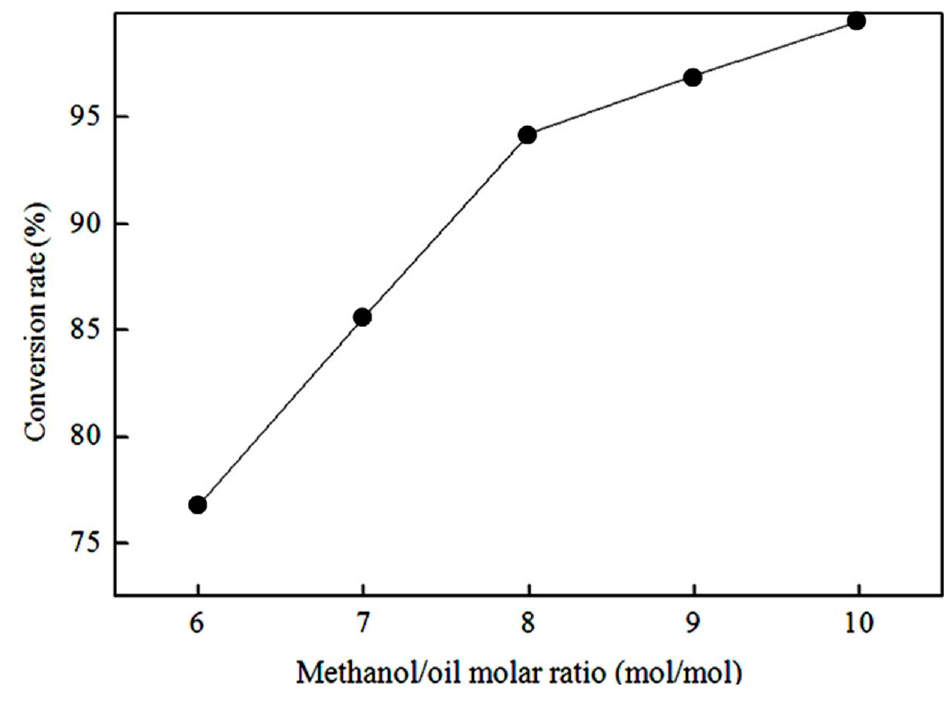
Figure 6. Effect of methanol/oil molar ratio on the biodiesel conversion. Table 2. Effect of catalyst amount on the biodiesel conversion.